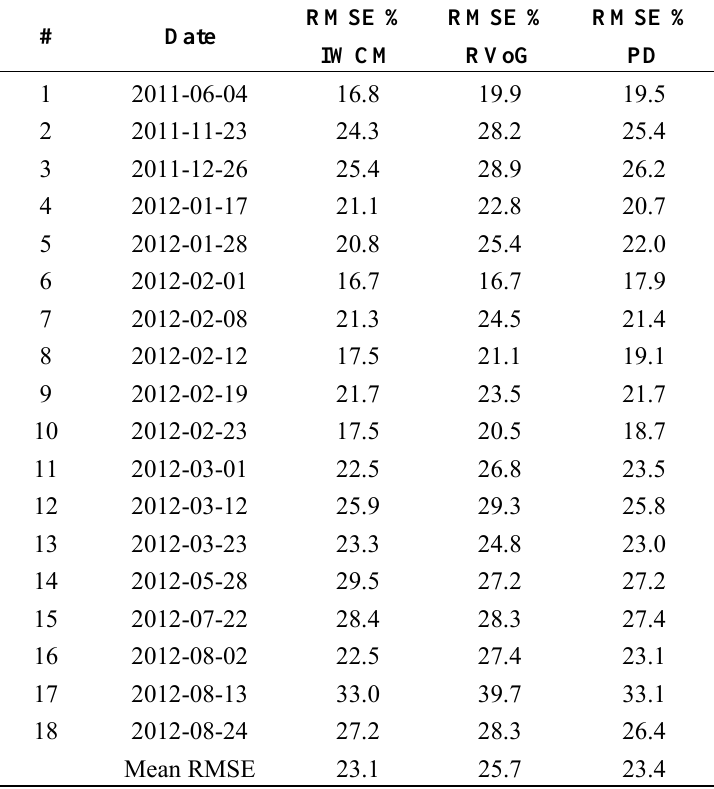
Table 4. Single-image relative RMSE for the biomass estimated using the models IWCM, RVoG, and PD.